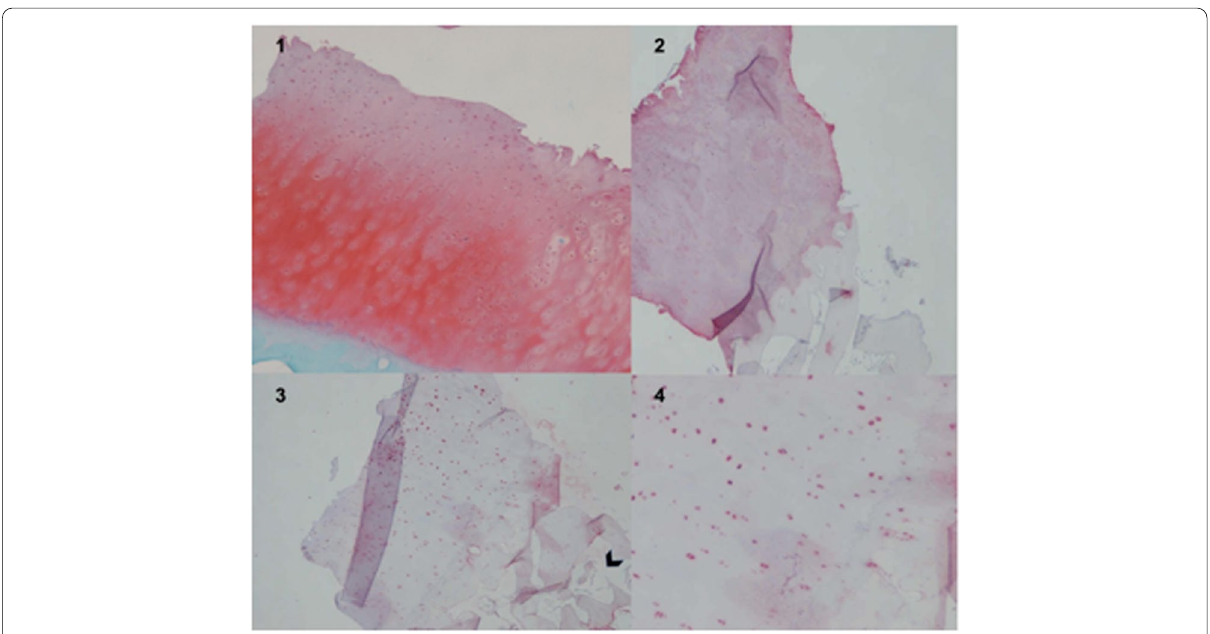
Fig. 7 Safranin-O/Fast Green highlights the presence of a fairly organised cartilage structure ( 1 ). Immunohistochemical evaluation for type II collagen showed positivity, especially at the level of the extracellular matrix ( 2 ). Immunohistochemical evaluation for type I collagen showed positiveness at the cellular level. Delamination is present above the tidemark, black arrow. ( 3 , 4 ). 370